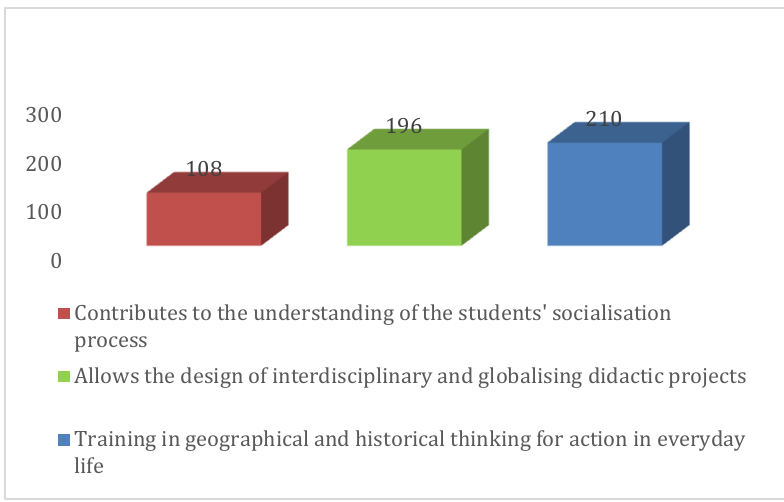
Figure 1. Usefulness of the social sciences.